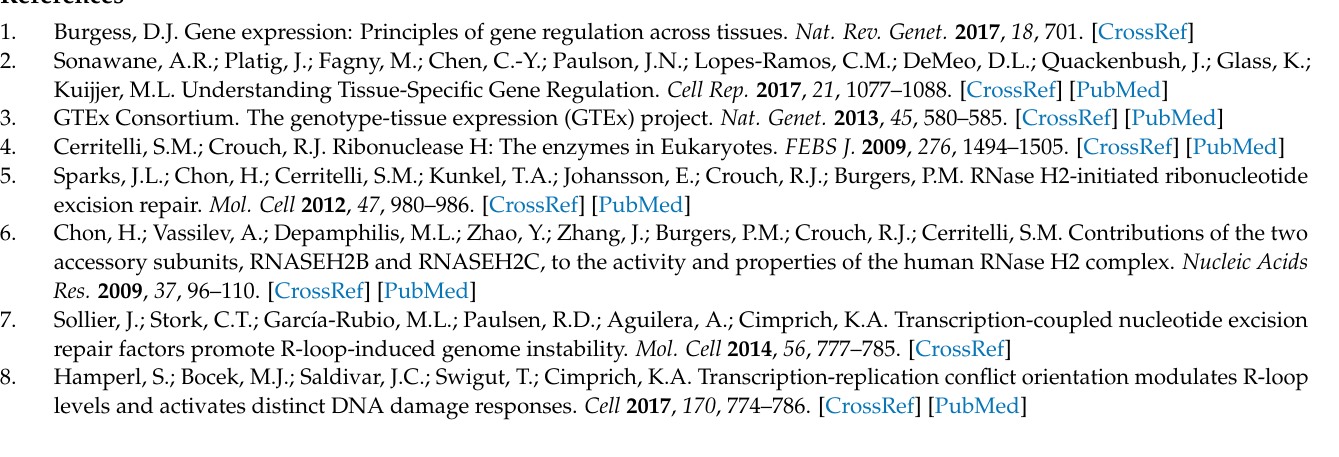
functional network of genes involved in DNA replication. Table S7: List of RNASEH2B co-expressed correlated genes. Table S8: Expression level of the RNASEH genes in cancer using data obtained from Cancer RNA-seq Nexus (CNR) in 29 different randomly selected tumors. Table S9: Expression level of the RNASEH genes in cancer using data obtained from Cancer. RNA-seq Nexus (CNR) in different tissues at different stage of cancer progression. Table S10: Level of the RNASEH genes throughout the progression of cancer showing constant upregulation of RNASEH2A in lung, breast, and bladder tumors. Table S11: Level of the RNASEH genes at different stages of cancer. Table S12: (a) Average expression of patients with different RNASEH2A copy-number alterations from GISTIC in TCGA Pan Cancer studies; (b) raw data for RNASEH2A mRNA expression with copy number alteration type in TCGA Pan Cancer studies. Table S13: Mass spectrometry results of first run (4a) and second run (4b) of immunoprecipitation experiments. Table S14: (a) Count and percentage of Cancer Cell line types in CCLE database; (b) count and percentage of cancer tissue types/subtypes in TCGA Pan Cancer Dataset. Table S15: (a) Correlation Matrix (Pearson’s R and p-value) for RNASEH2A and 39 subset list of genes in CCLE; (b) correlation Matrix (Pearson’s R and p-value) for RNASEH2A and 39 subset list of genes in TCGA. Table S16: Gene ontology of the 2% co-expressed correlated CDK1 genes and G3BP1 using the GOrilla analysis tool showing enrichment of genes involved in cell cycle regulation and in molecular binding of RNA. Table S17: List of CDK1 co-expressed correlated genes. Table S18: List of G3BP1 co-expressed correlated